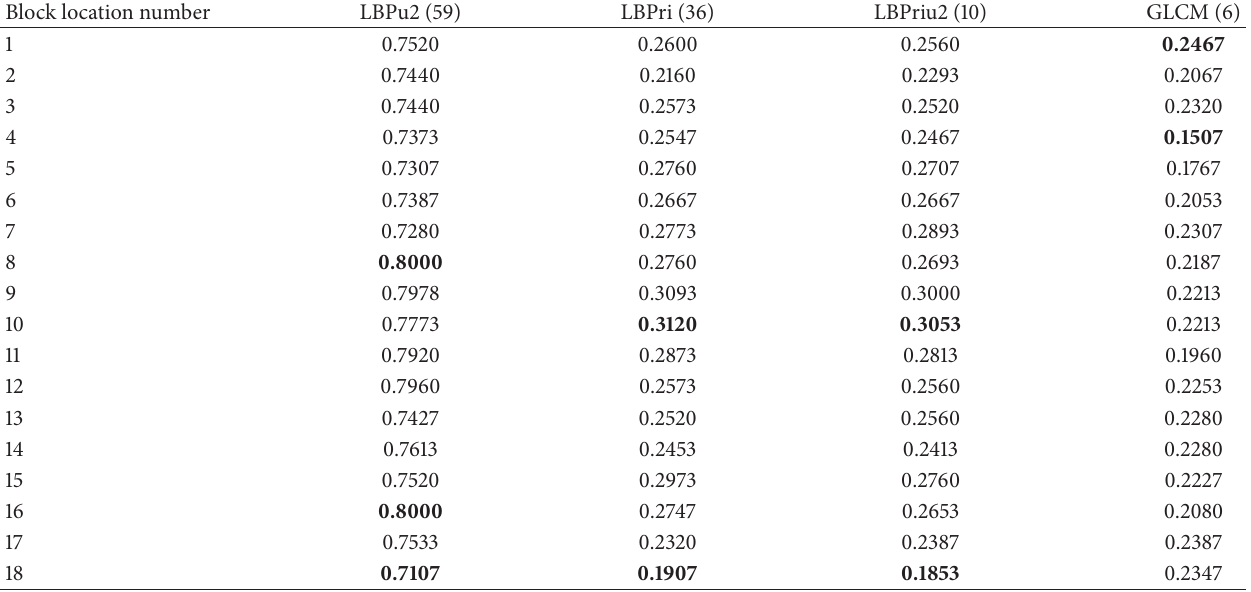
Table 4: Independent block recognition rate.